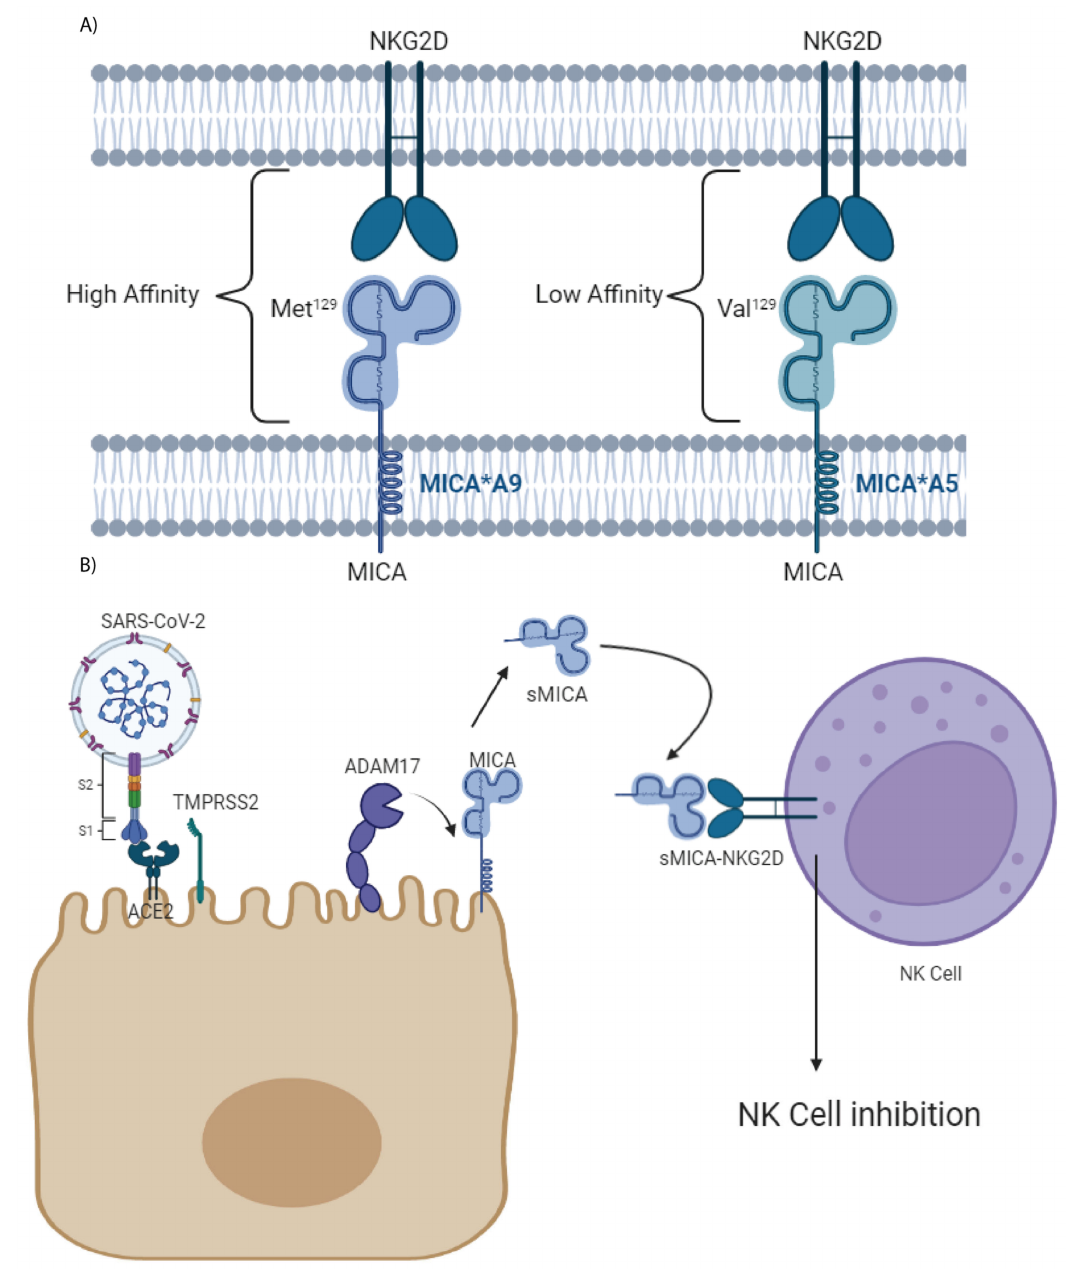
Figure 1. Graphic representation of the MICA-NKG2D interaction depending on the Met/Val polymorphism at 129 and the production of sMICA by ADAM17: ( A ) The Met/Val polymorphism at 129 of the MICA molecules influences binding to NKG2D. Alleles with Met 129 have high affinity for the ligand, while those with Val 129 have low affinity. The MICA*A4 and *A9 alleles have Met 129 , MICA*A5 present Val 129 , and the MICA*5.1 and *A6 alleles can have both polymorphisms [20]. ( B ) In COVID-19 infection, the metalloprotease ADAM17 hydrolyzes MICA generating sMICA, which binds to NKG2D causing inhibition. In the case of the MICA alleles with the Met129 variant, the inhibition will be greater, and there will be a worse control of the infection by the NK and